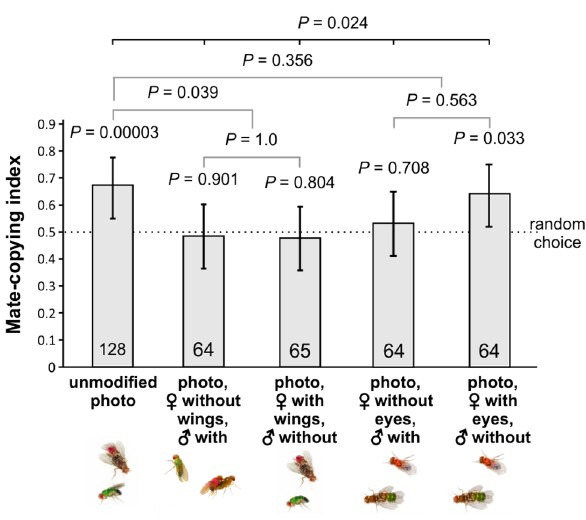
Figure 7. Effect of modifications on the initial photo on mate copying. All treatments include a mixture of lateral or top views of the copulating pair. Statistics above bars: P values of the binomial tests of departure from random choice (represented by the dashed line); above the horizontal bars: P values of binomial tests of a GLMM testing the treatment effect within each panel. The grey horizontal bars provide the P values of a Fisher test to compare treatments pairwise. We used Holm’s correction for multiple testing. Error bars: Agresti-Coull 95% confidence intervals. For examples of the pictures used see Fig.